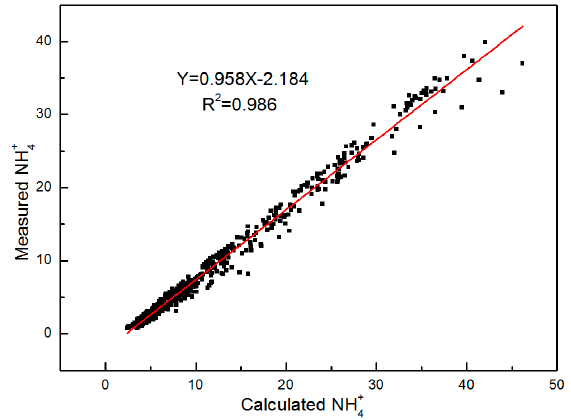
Figure 4. Comparison of measured and calculated NH 4+ mass concentrations (the red line represents slope, R 2 ).